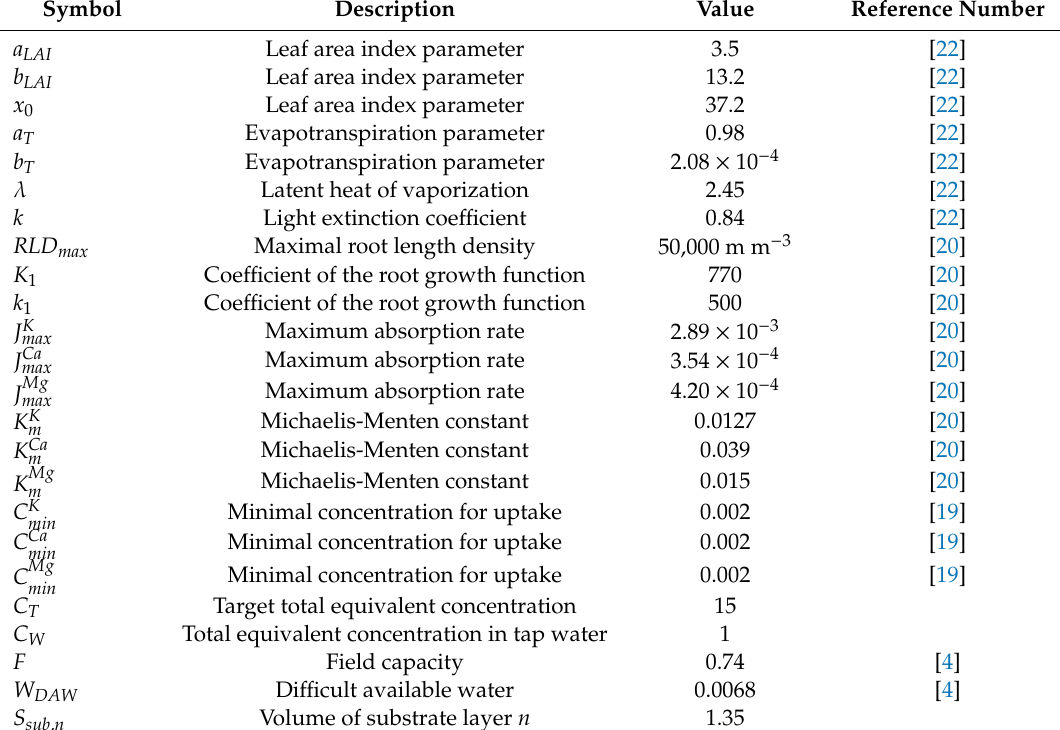
Table 1. Parameters used for the simulations of soilless culture system.